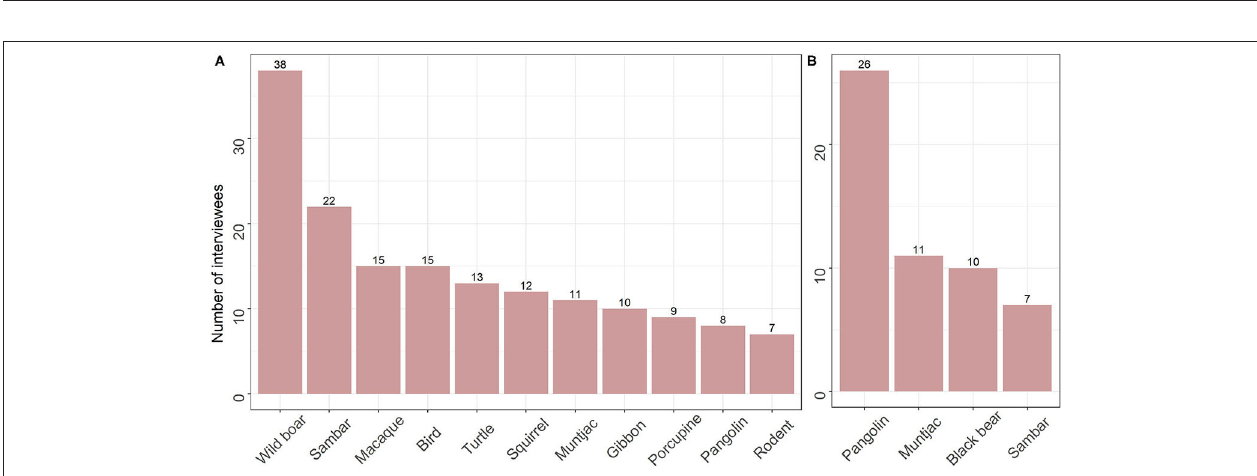
FIGURE 3 | (A) Wild animals that at least five interviewees thought have declined ( n = 81). (B) Wild animals that at least five interviewees thought have been locally extirpated ( n = 60).